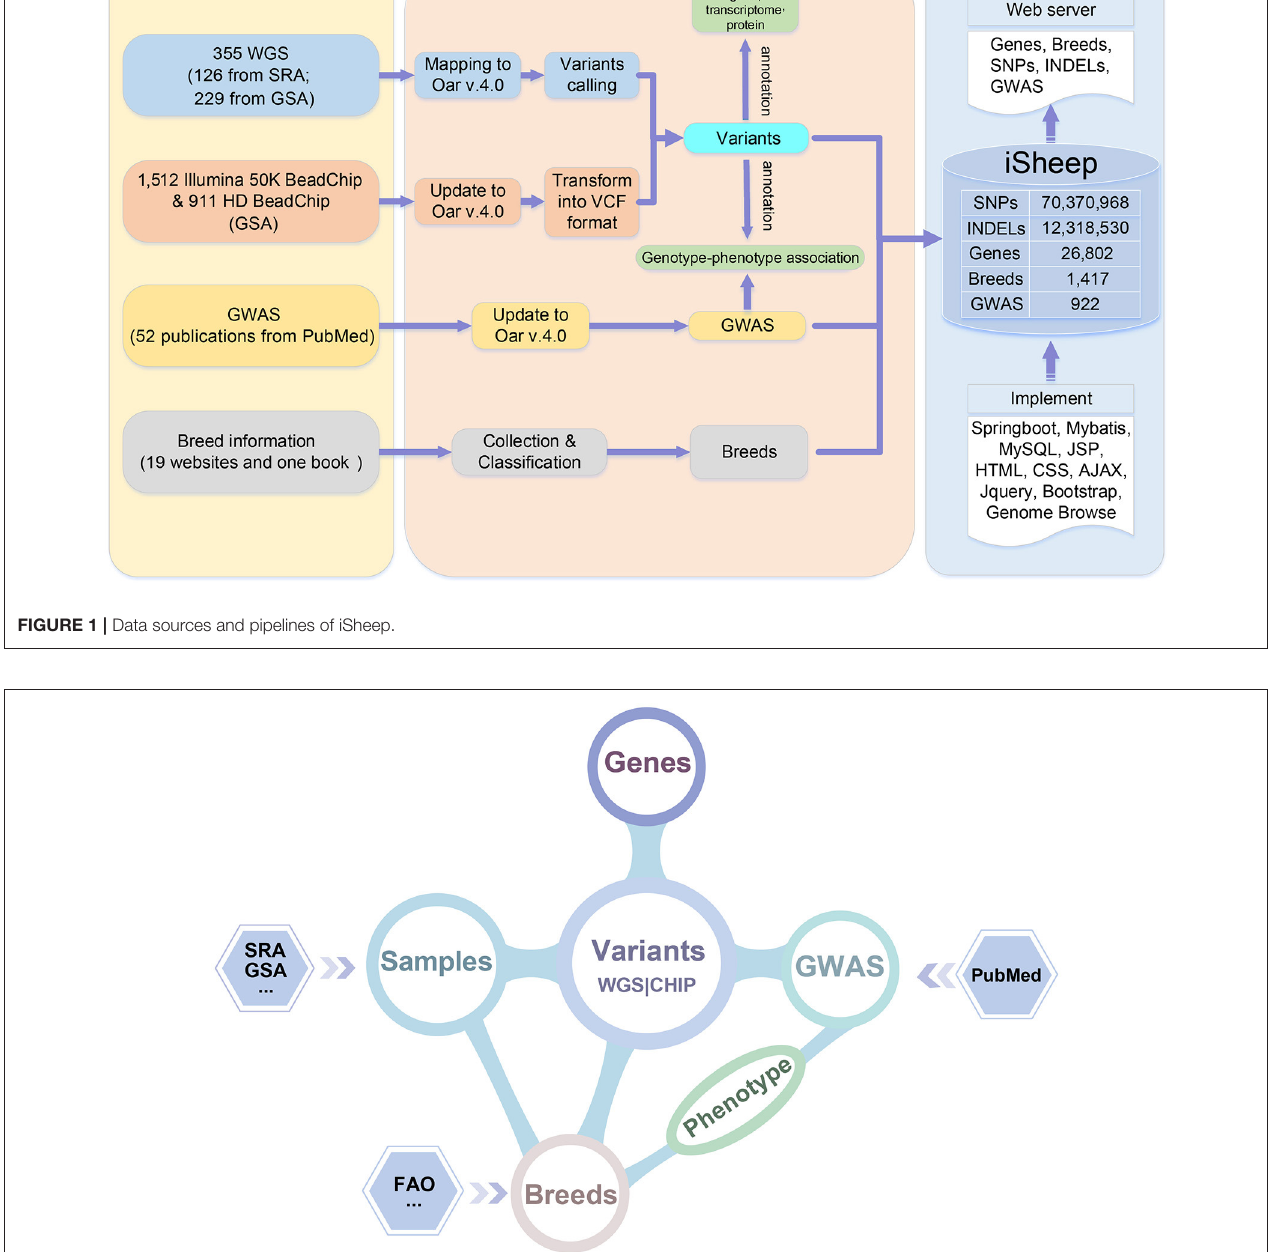
( Figure 2 ). In details, we collected whole-genome sequencing (WGS) data of 355 sheep, SNP BeadChip data of 2,423 sheep,